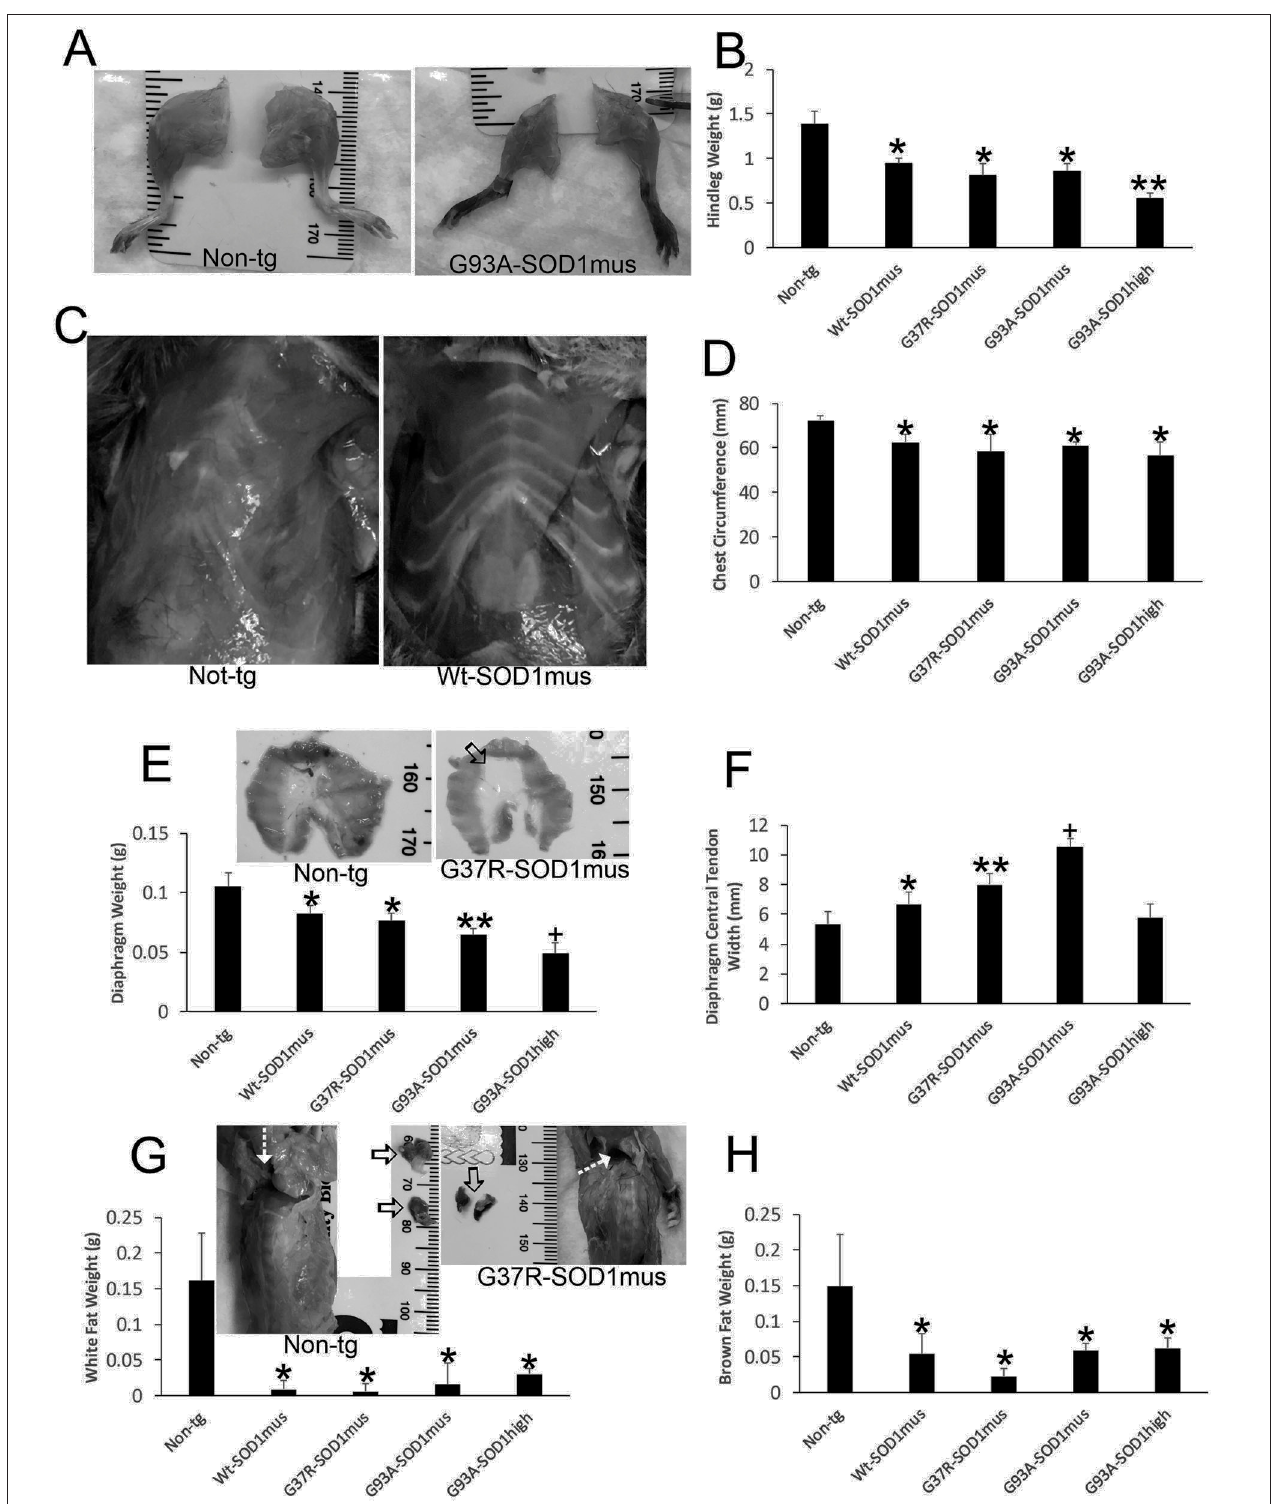
FIGURE 2 | Gross anatomical pathology of hSOD1 mus mice. (A) Hindlegs of non-tg mice and hSOD1 mus mice showing the gross atrophy of the latter. (B) Graph of hindleg weights (mean ± SD) in age-matched non-tg mice and hSOD1 mus mice. Non-age-matched G93A-hSOD1 high expressing mice (74) were used as a